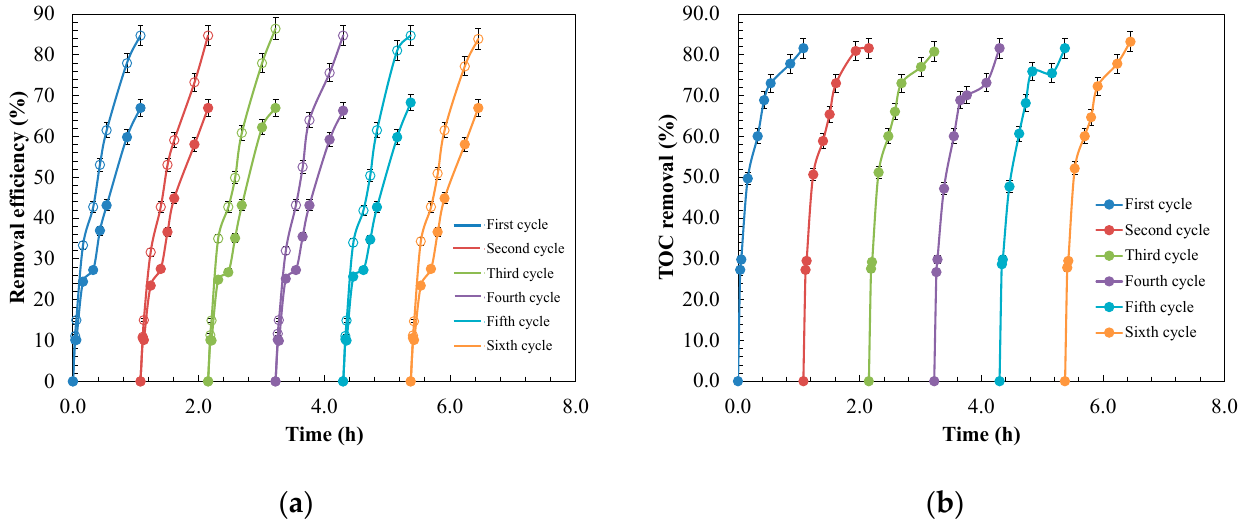
Figure 15. Reusability test for the photocatalytic degradation of ANI and BTH within six repeated cycles using MnO 2 /GAC-3 catalyst. Evolution of: ( a ) primary degradation of ANI ( ○ ) and BTH ( ● ); ( b ) mineralisation. Experimental conditions: C 0 = 12.0 mg L − 1 ; pH = 9.0; m CAT = 0.9 g L − 1 ; Irradiation dose = 155.8 W m − 2 ; T = 26 °C.